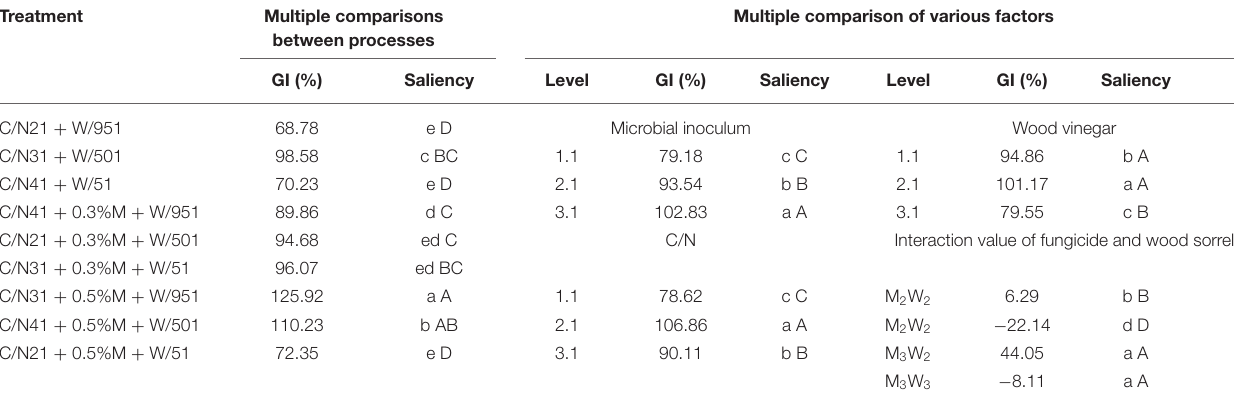
TABLE 8 | Significance test of difference between different treatments and factor effect.